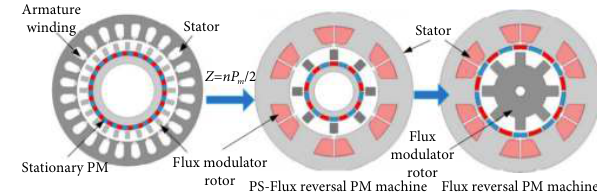
Fig. 18 Topology transferring from basic model to flux reversal PM ma- chines (reprinted with permission from Ref. [57], © 2015 IEEE).